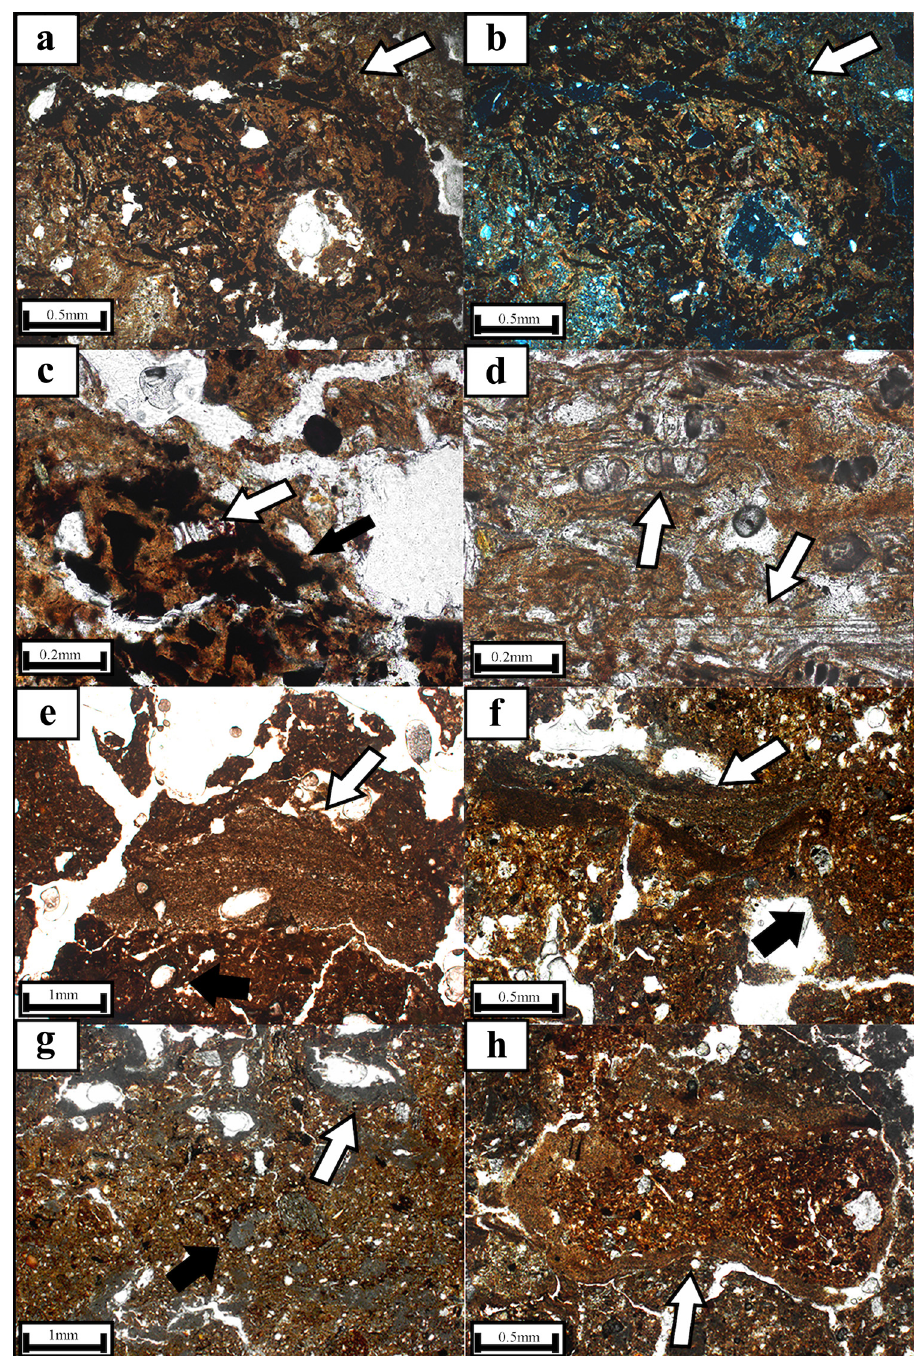
Figure 10: Photomicrographs. ( a ) PPL and ( b ) XPL showing the dung features identi fi ed in thin section 108B. White arrows identify the rolled - up structure of fi brous organics within a highly birefringent fi ne material. ( c and d ) White arrows show phytolith - microscopic silica casts formed inside of plant matter. Black arrows indicate black organic matter. Together, images ( a ) – ( d ) show the organic - derived components of the deposit indicating some biogenic origin to the fi ll. ( e and f ) White arrows indicate slacking, shallow deposits of ponded sediment with graded bedding. Black arrows indicate “ dusty ” coatings of void structures that are formed through the percolation of water after the deposition of the deposit. White arrows indicate “ dusty ” coatings surrounding voids ( g ) and ceramic fragments ( h ) . Black arrows indicate a void that has been in fi lled by the same water percolation forming the “ dusty ” coatings. Images ( e ) – ( h ) show that water had a clear in fl uence on the groundmass. Prepared by Ada